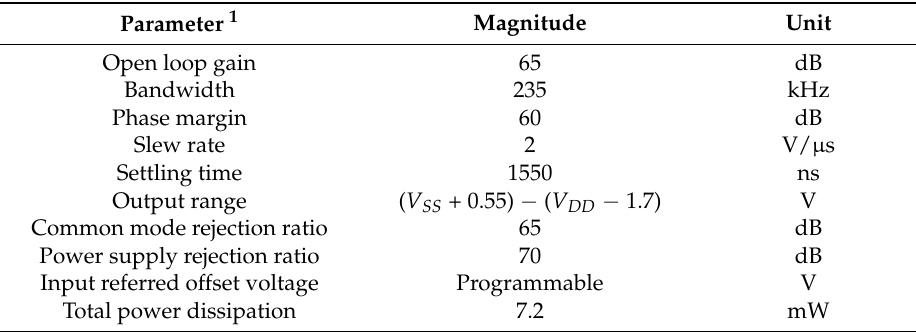
Table 1. The main POOA’s electrical parameters.